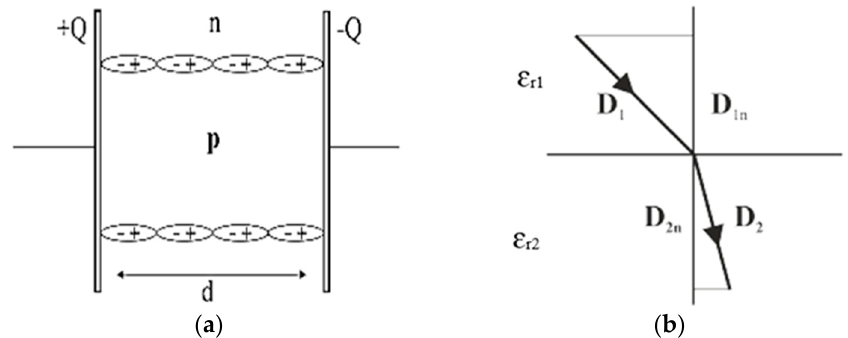
Figure 1. ( a ) Polarized atoms inside an electric field; ( b ) electric displacement field at the interface of different materials.